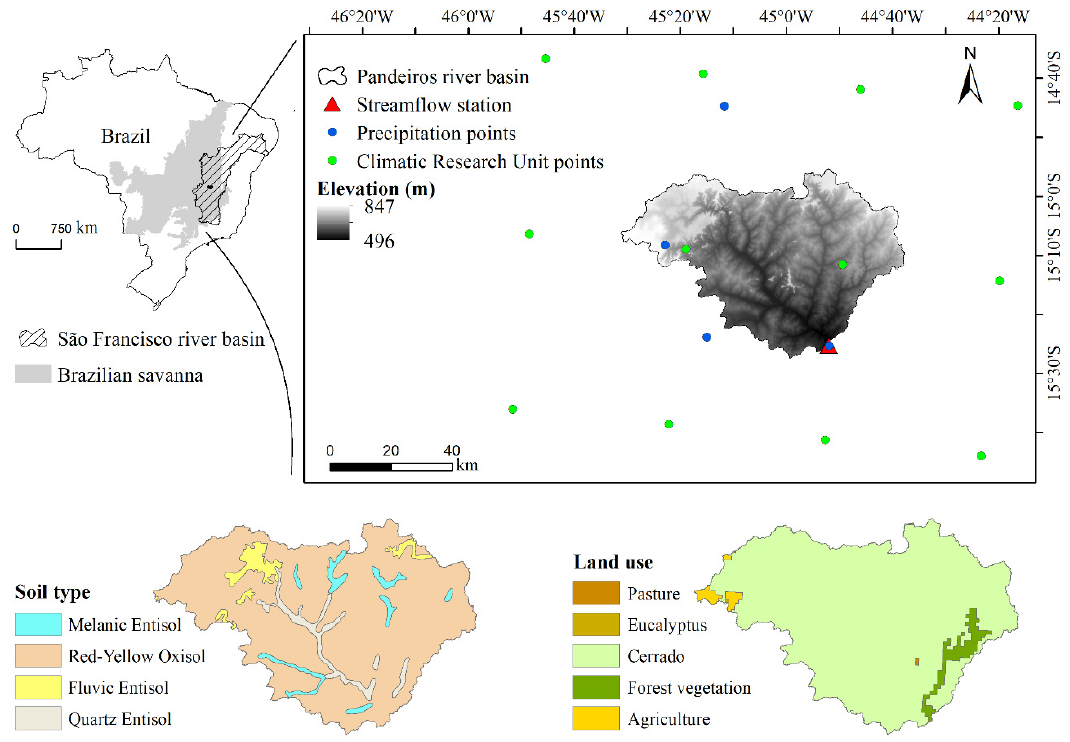
Figure 1. Location of PRB and its DEM, hydrometeorological data, and soil and land use maps.